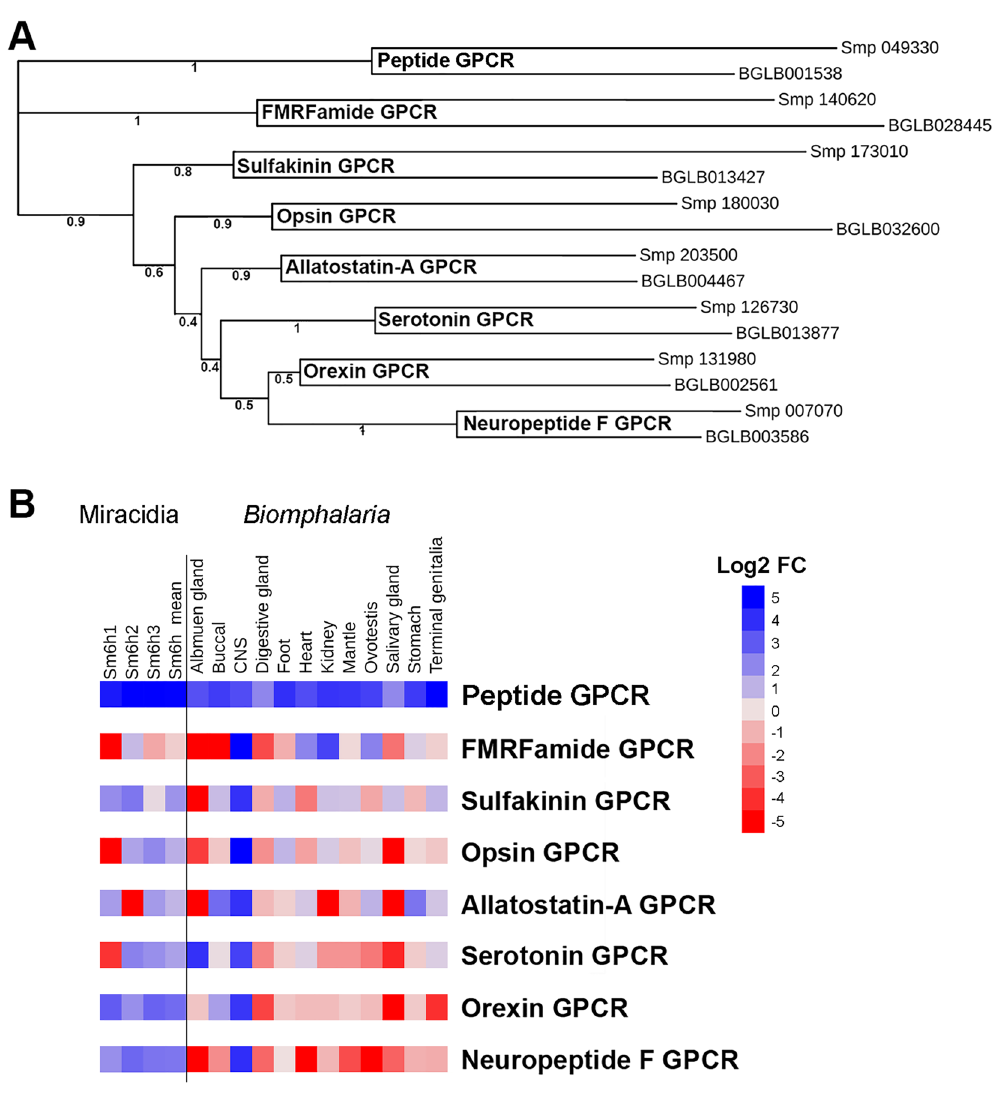
Figure 2. Characterization of GPCR orthologs shared between B. glabrata and S. mansoni miracidia. ( A ) Phylogenetic tree analysis of shared GPCRs, where each B. glabrata GPCR clusters with an ortholog receptor from S. mansoni . Bootstrap values support the confidence levels of clades. ( B ) Heatmap showing expression of shared GPCR- (in TPM) encoding genes in S. mansoni miracidia at 6 h post-hatch and different B. glabrata tissues. The columns represent S. mansoni miracidia biological replicates (1–3) and their mean, as well as Biomphalaria ( glabrata )